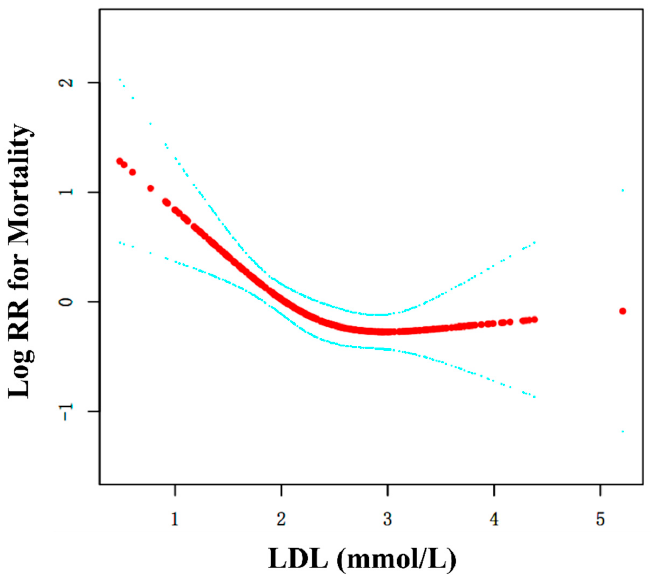
Figure 1. Curve fitting between LDL and mortality. Adjusted for age, sex, CHD, arrhythmia, dementia, treatment strategy. The red line is the fitting curve, and the blue lines are 95%CI. Table 3. Nonlinearity of LDL and mortality.